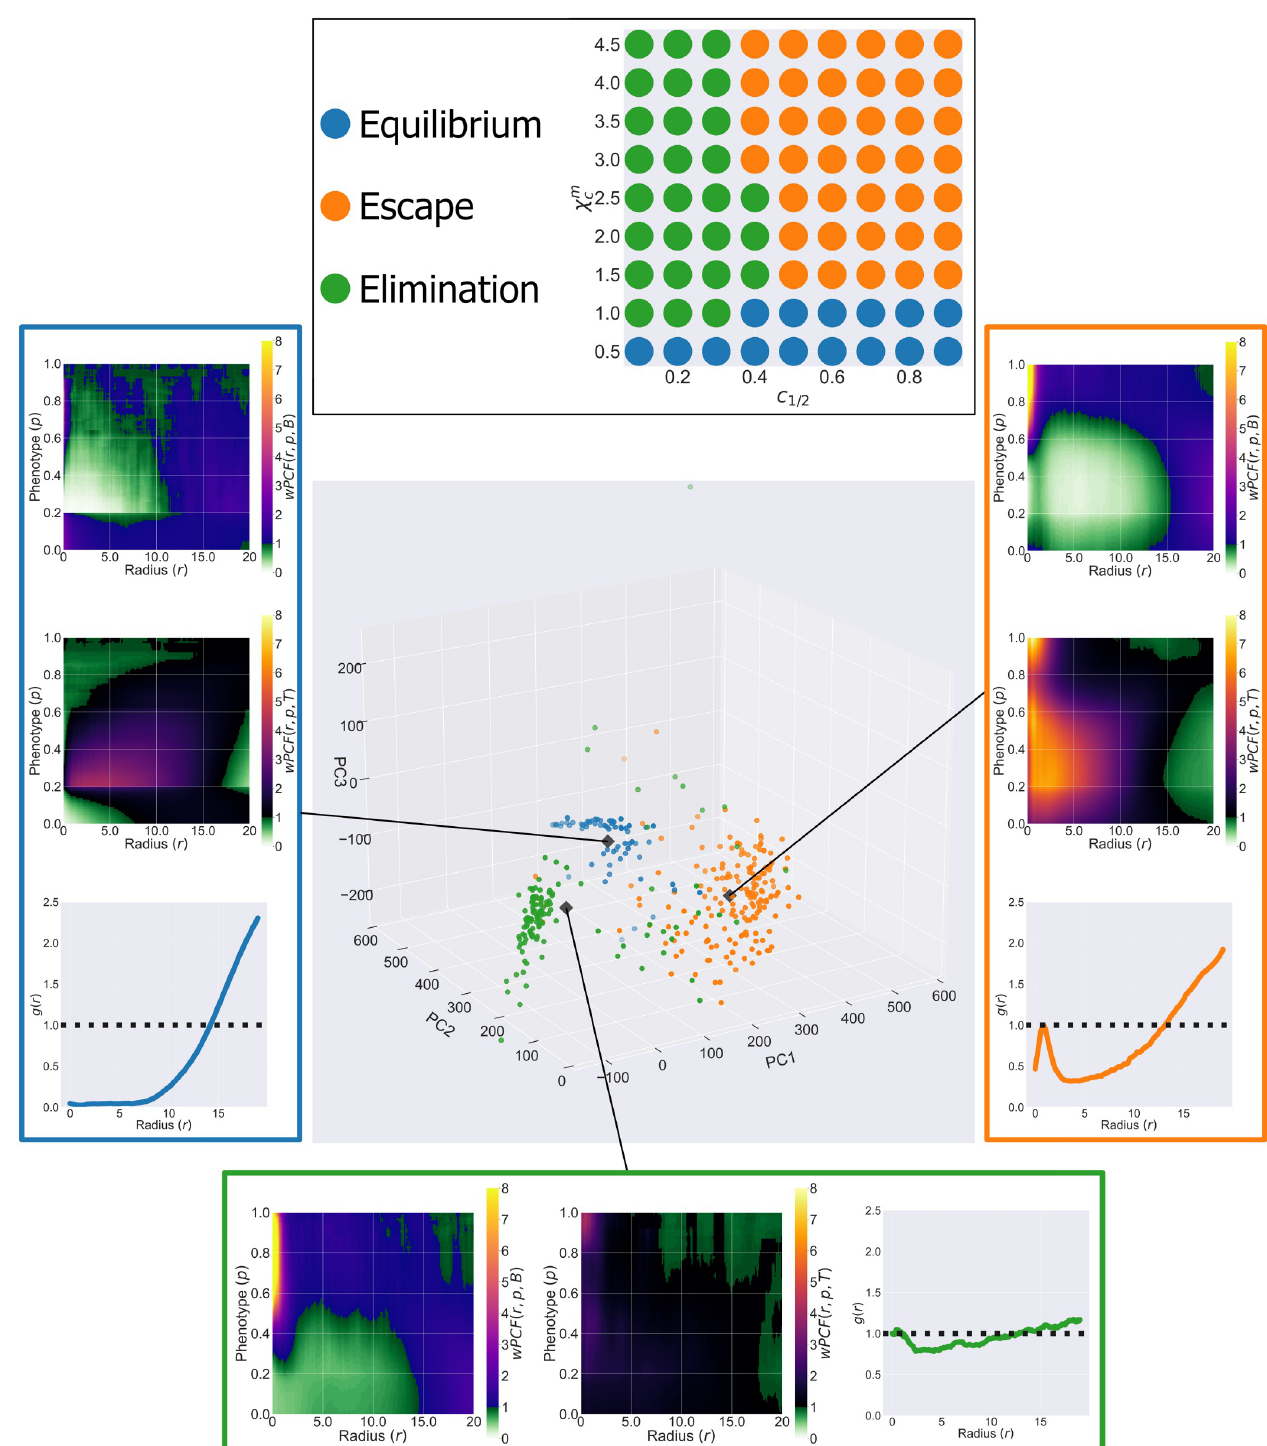
Fig 7. Projecting PCF signatures onto their first three principle components resolves the 3 Es of immunoediting. Top: labels assigned to each parameter combination at t = 500. Labels are manually assigned based on the predominant behaviour observed across all realisations of that parameter set. Main: Projection of the vectorised PCF signatures from outputs at t = 500 of 371 ABM simulations onto their first three principal components. Simulations cluster according to their label (manually defined as Escape, Elimination or Equilibrium as per the inset above). The top 100 principal components for the centroid of each cluster have been converted back into wPCF and cross-PCF signatures, and the corresponding wPCF ( r , p , B ), wPCF ( r , p , T ) and g Each inset has the same interpretation as the PCF signatures in Fig 6, showing that conversion between PCF signatures and PCA-space is straightforward.